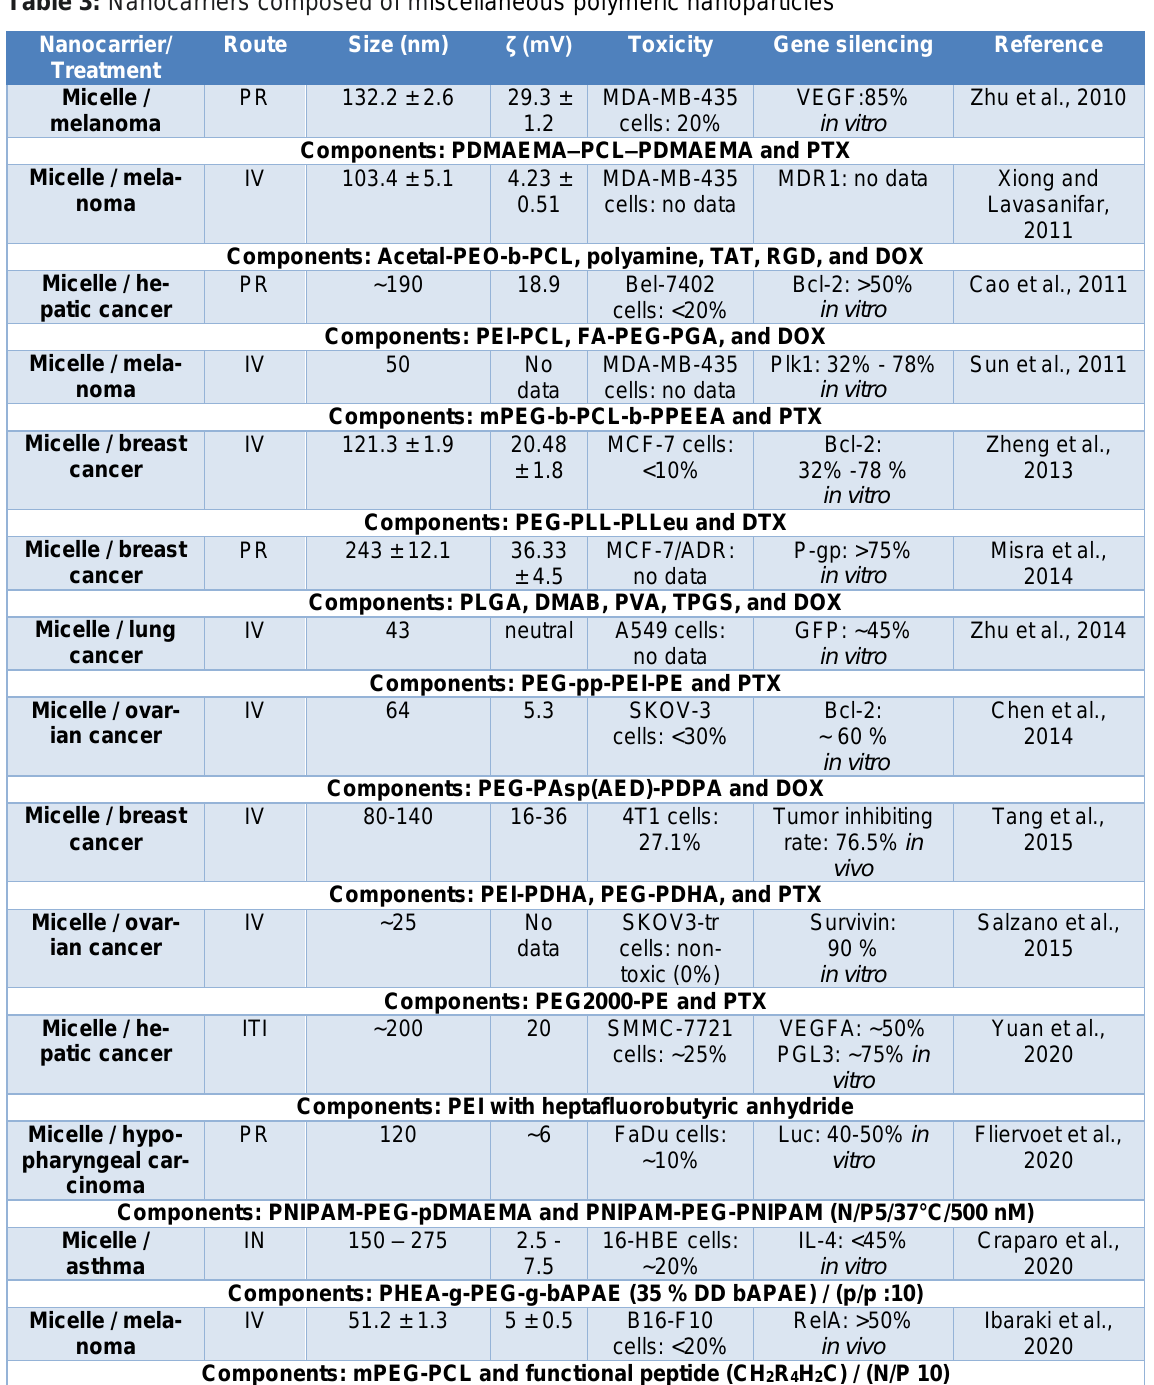
Table 3: Nanocarriers composed of miscellaneous polymeric